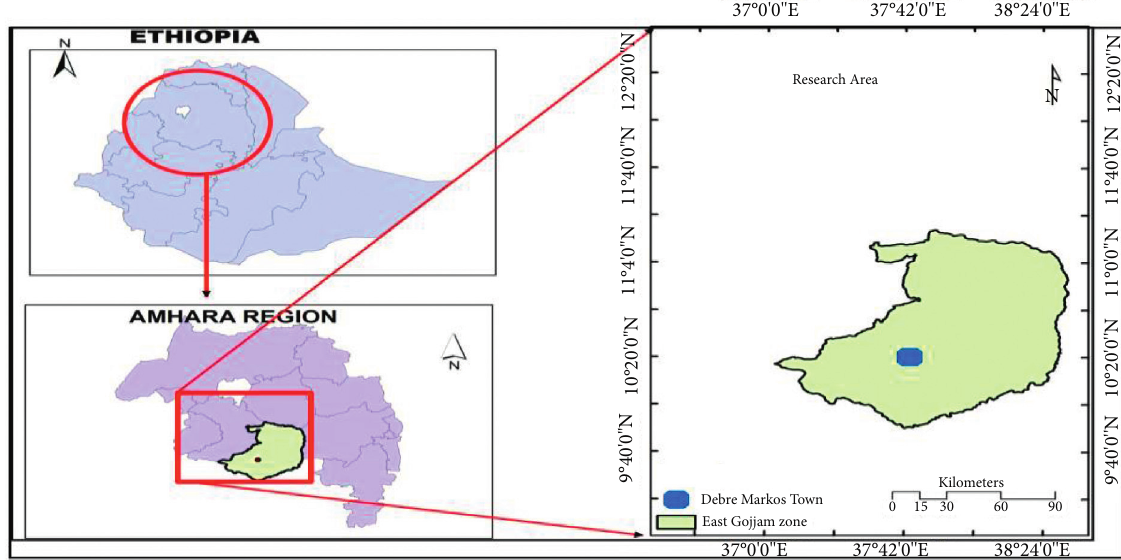
Figure 1: Location of the study